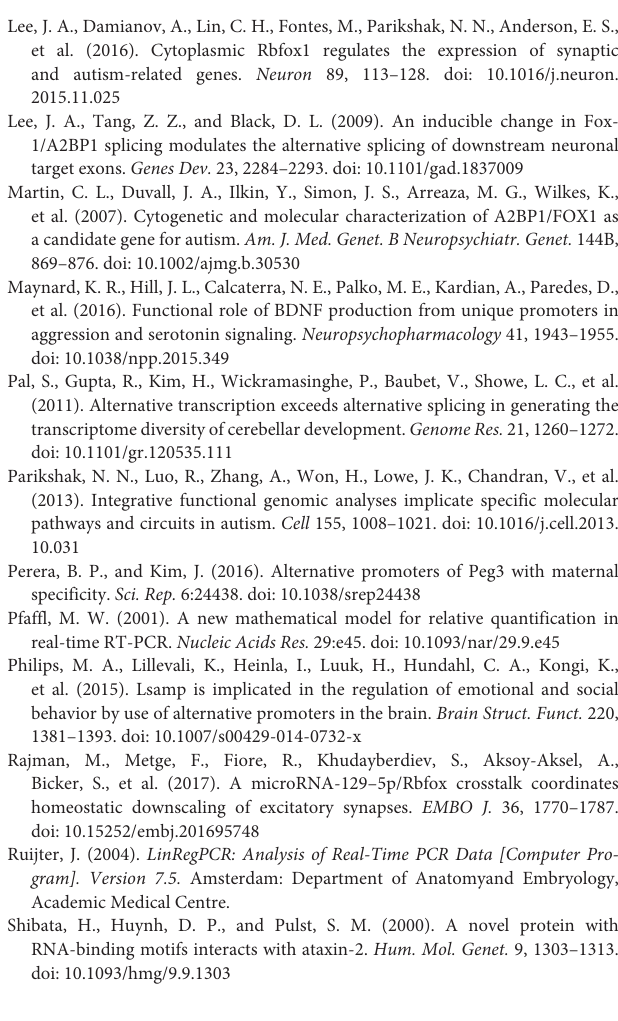
FIGURE S1 | Rbfox1 transcript identification in the cerebral cortex. All spliced Rbfox1 transcript variants that were detected by Iso-Seq in the P0 cerebral cortex